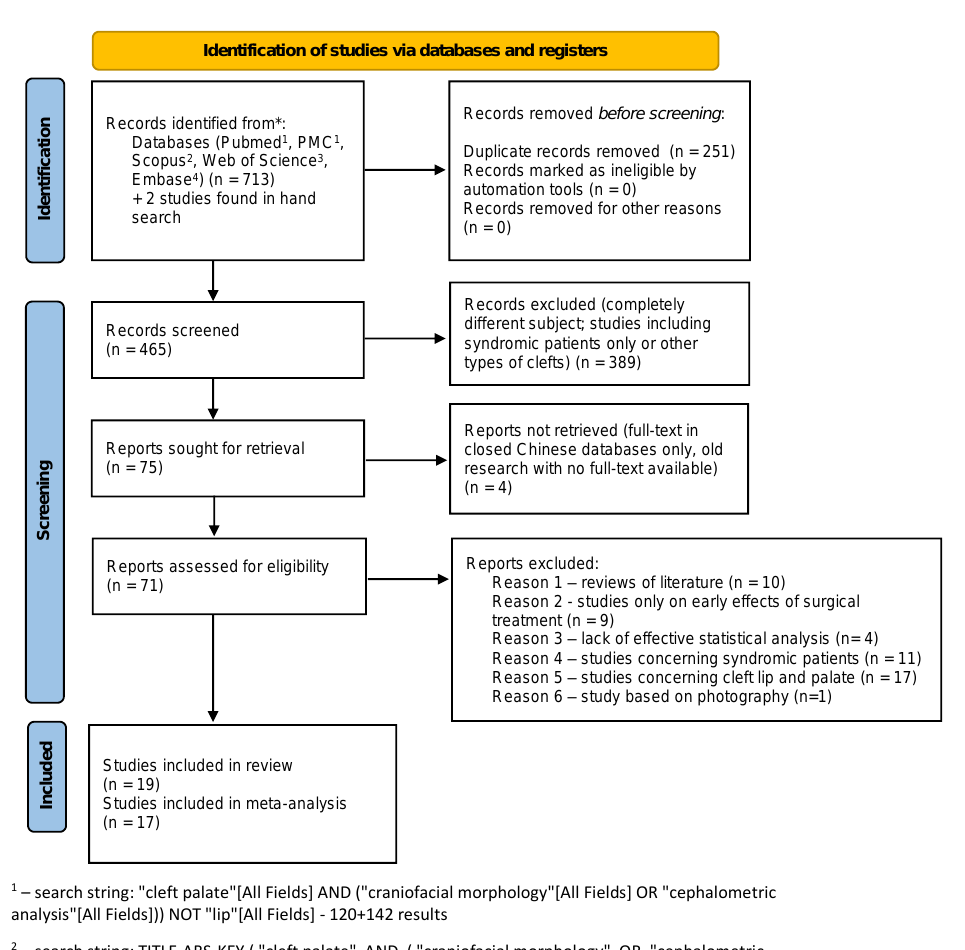
Figure 1 . Prisma 2020 flow diagram . Figure 1. Prisma 2020 flow